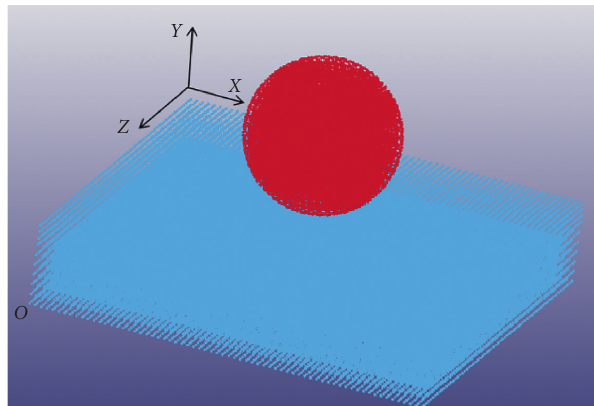
Figure 8: SPH numerical model.